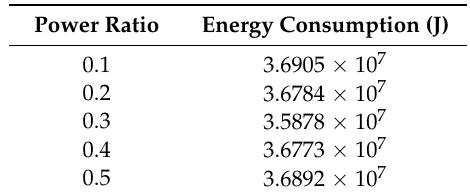
Table 2. The total consumed-energy for the vehicle with the power ratio of the front-axle motors varies from 0.1 to